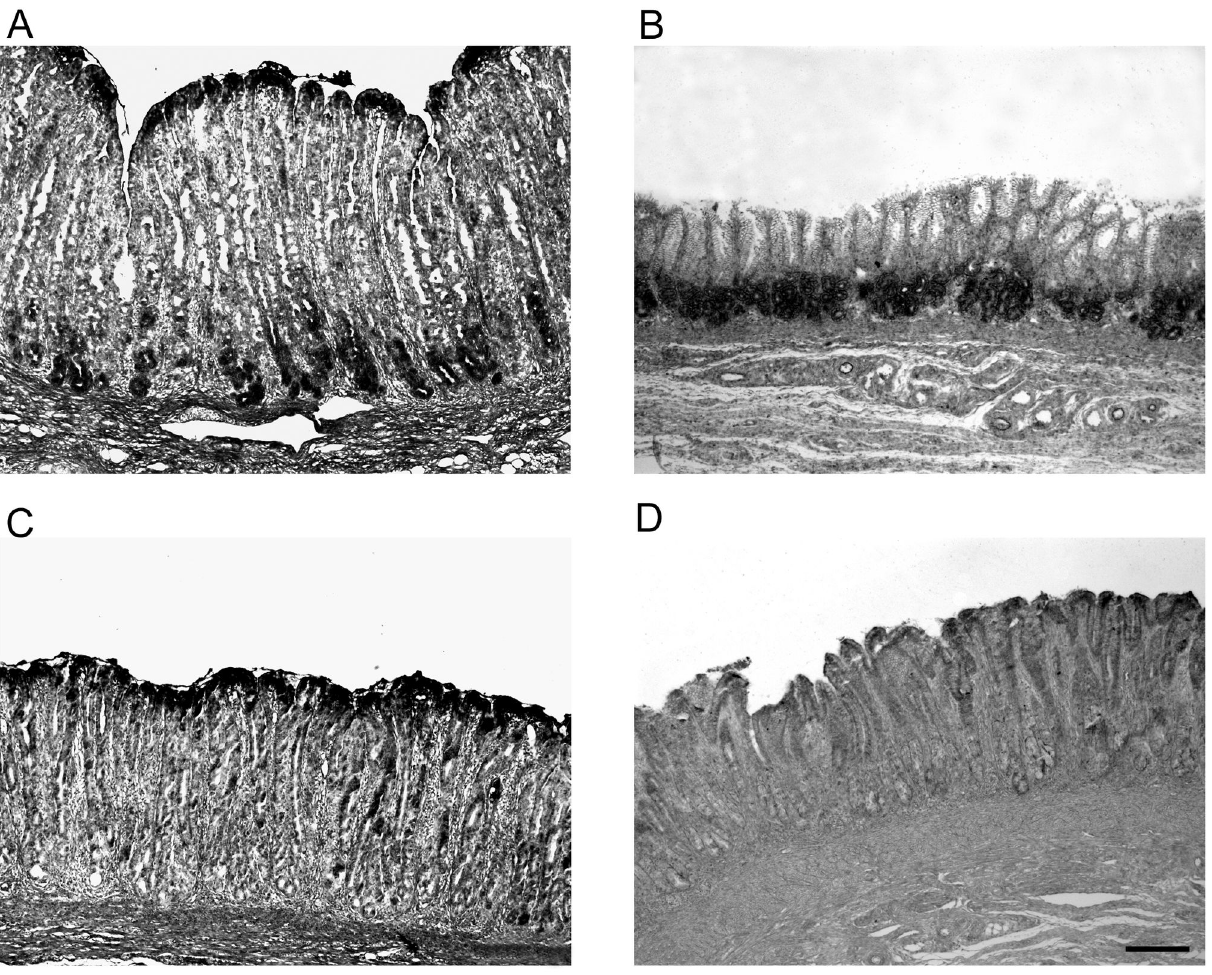
Figure 5. Localization of polymeric immunoglobulin receptor (pIgR) mRNA by in situ hybridization in the gastric mucosae of a representative pig aged 42 days. PIgR mRNA localization in a 42 day-old representative piglet, in the transition from cardiac to oxyntic mucosa (A), in the proper glandular region (oxyntic mucosa) (B) and in the pyloric region (C). Control with the sense probe is to ensure specificity of the reaction (D). Bar indicates 200 µm (50× magnification). doi: